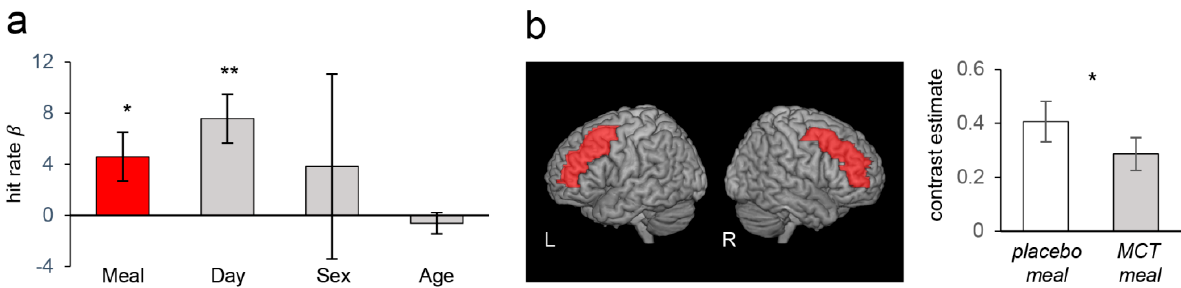
Figure 4. Behavioural and fMRI results of analyses in the high group. ( a ) The effects ( β weights) on the hit rate in the 2-back condition in the N-back task based on meal (MCT/placebo), day (1st/2nd visit), sex, and age. Consuming the MCT meal significantly improved the hit rate. Error bars depict SEMs; * p < 0.05, ** p < 0.01. ( b ). fMRI BOLD analysis. Left: bilateral DLPFC region of interest (ROI) used in the BOLD analysis (red areas). Right: Consuming the MCT meal significantly decreased the BOLD response to the working memory load during the N-back task. * p < 0.05.